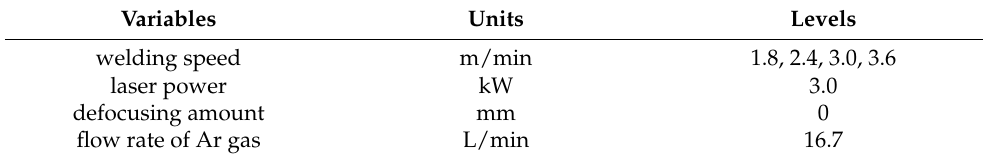
Table 2. Process variables in the experiments.